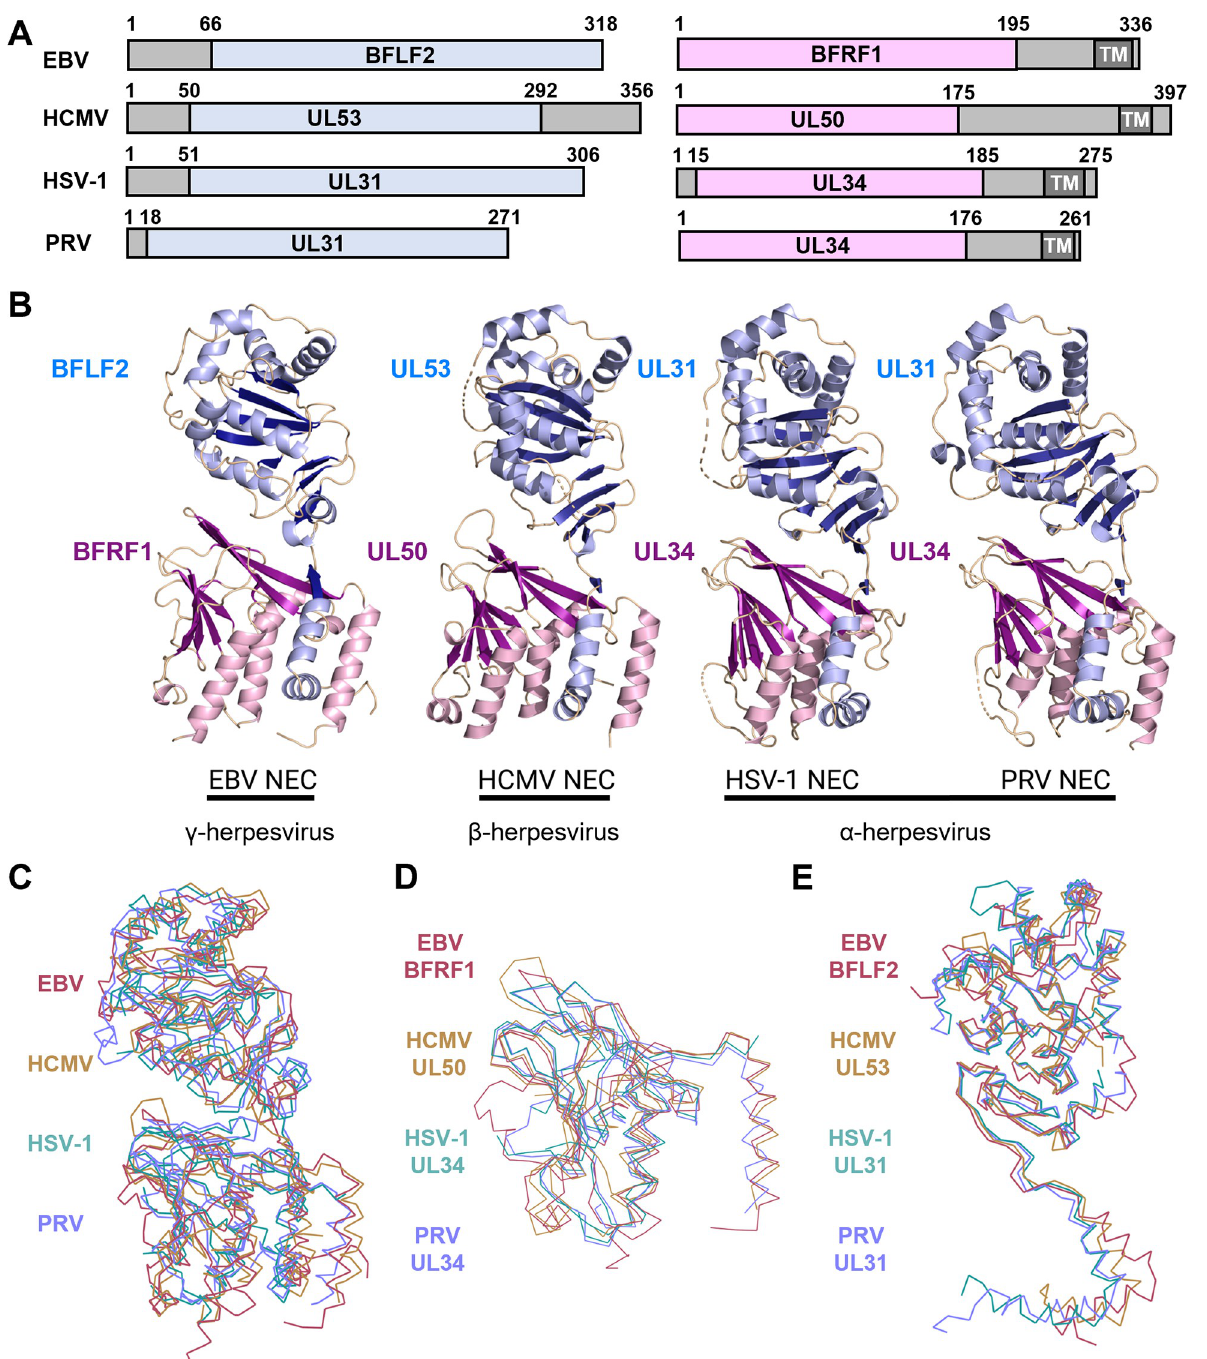
Fig 2. Crystal structure of EBV NEC and homologs. (A) Schematic depicting construct boundaries for the NECs from EBV (rcsb pdb 7t7i), HCMV (rcsb pdb 5d5n), HSV-1 (rcsb pdb 4zxs) and PRV (rcsb pdb 4z3u). BFLF2 and homologs are shown in blue while BFRF1 and homologs are shown in pink. Grey regions denote residues omitted from constructs with the transmembrane (TM) region in darker grey. (B) Crystal structures of homologous NECs depicted in (A). BFLF2 and homologs are shown in blue with light blue for α -helices and dark blue for β -strands. BFRF1 and homologs are shown in pink with light pink for α -helices and dark pink for β -strands. EBV NEC chains C+D are shown. (C) Ribbon overlay aligned to NEC2 (Chains C+D) for NEC homologs. EBV (dark red), HCMV (gold), HSV-1 (light teal), PRV (light purple) (D) Ribbon overlay aligned to EBV chain C for the BFRF1 homologs. Same coloring as (C). (E) Ribbon overlay aligned to EBV chain D for the BFLF2 homologs. Same coloring as (C). Images created in PyMol [44] and BioRender.com.